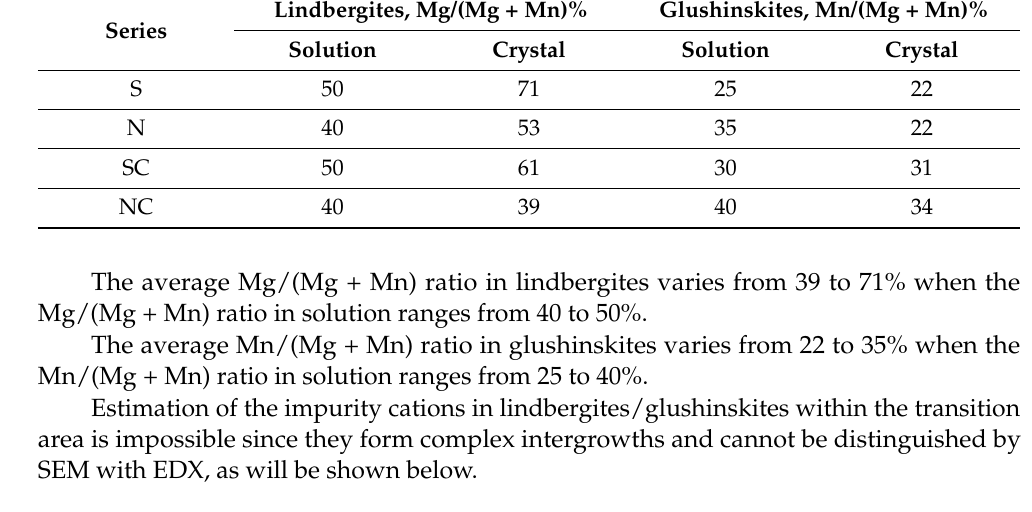
Table 3. Limiting concentrations of Mg/Mn in lindbergites/glushinskites within single-phase precipitates.